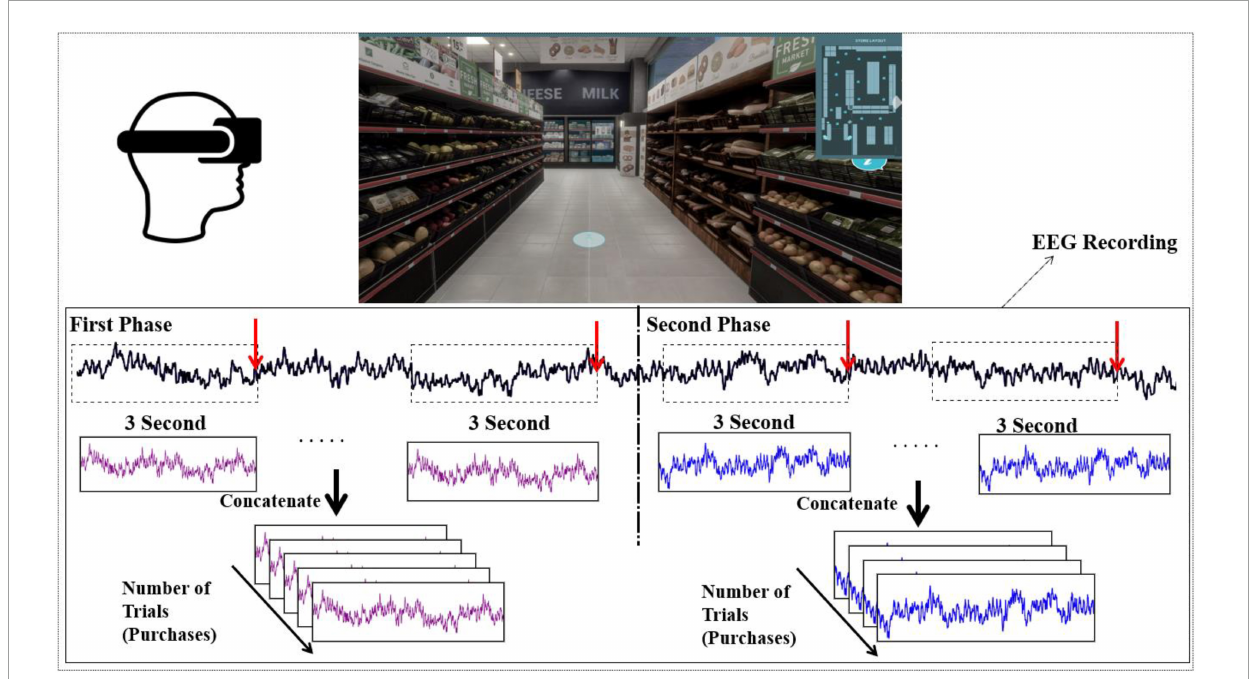
FIGURE1 The environment for virtual supermarket and EEG data collection procedure is presented. The red arrows show the time points in which they choose a product. We consider the 3 s data before that event as a trial. Afterward the trials for each condition have been concatenated for further analysis.